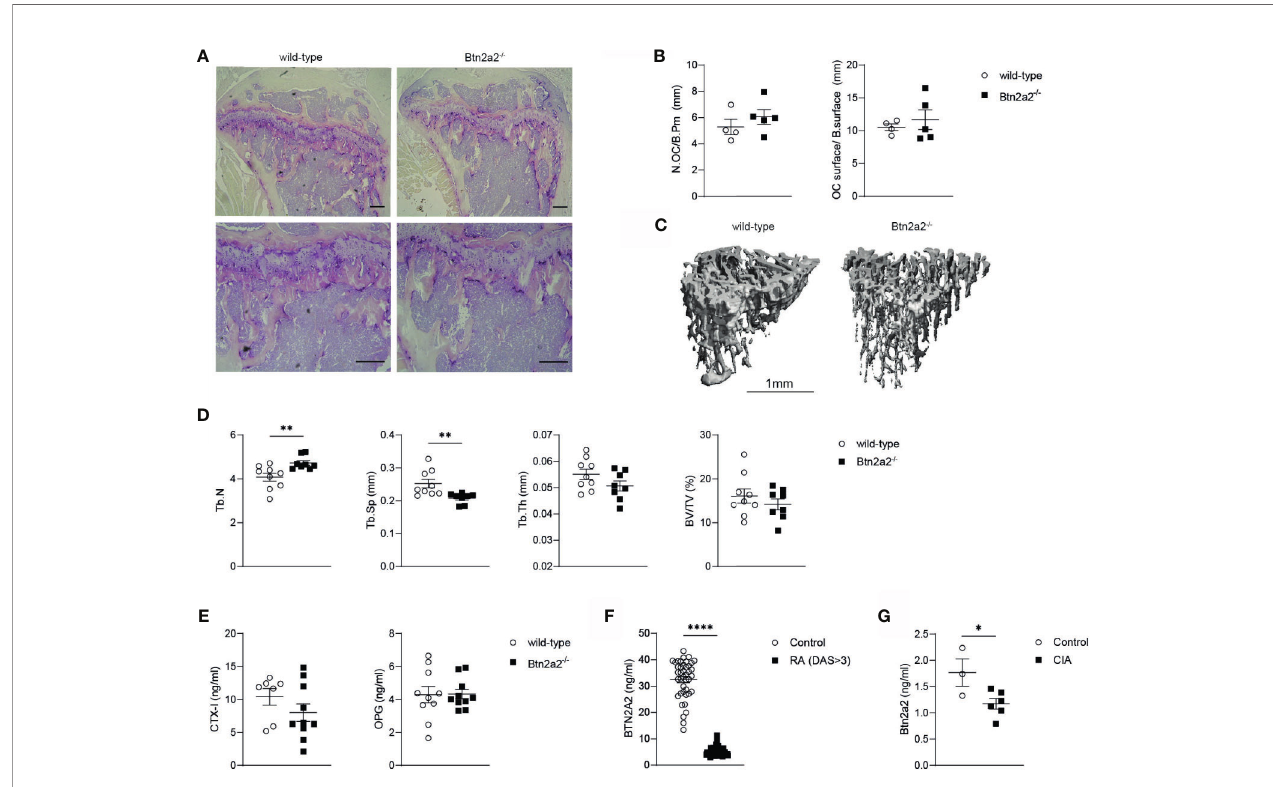
FIGURE 4 | Loss of Btn2a2 changes bone architecture in vivo . (A) Representative Images of tibiae with TRAP staining of male Btn2a2-/- mice compared with their wild type littermates at 12 weeks of age. Scale bar indicates 200 m m. (B) Histomorphometric analysis of the number of osteoclasts per bone perimeter (N.OC/ B.Pm) and the osteoclast surface per bone surface (OC.surtace/B.surtace). (C) m CT images of the skeletal phenotype of male Btn2a2-/- mice and their wild-type littermates at 12 weeks of age. Scale bar indicates 1 mm. (D) m CT analysis of trabecular bone parameters of tibial bone including bone volume to trabecular volume (BV/TV), trabecular thickness (Tb.Th.), trabecular number (Tb number), and trabecular separation (Tb.Sp.). (E) Serum levels of CTX-1 and OPG from Btn2a2-/- mice and wild-type littermates at 12 weeks of age were measured by ELISA. (F) BTN2A2 serum levels from RA patients and healthy controls. (G) Btn2a2 serum levels from CIA mice compared to healthy controls at day 30 of CIA. Signi fi cance was assessed using Student's t-test. Date are shown as means ± SEM. *P < 0.05; **P < 0.01; ****p <